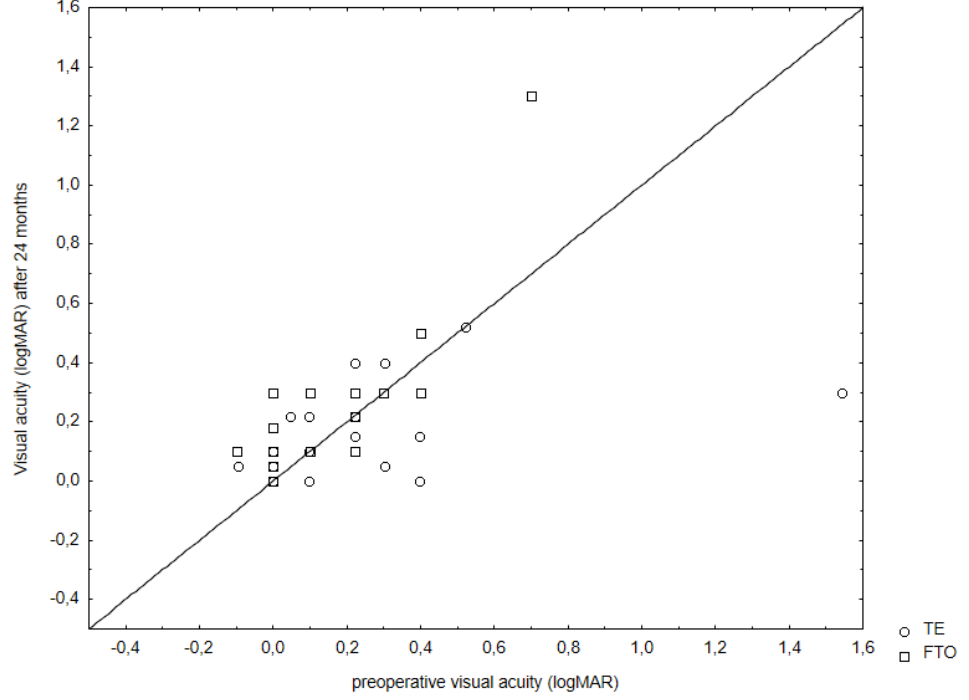
groups, for instance, patients undergoing tube shunt surgery with patients undergoing trabectome surgery 36,37 . By contrast, exact matching is well suited to compare similar pathological conditions and similar treatments, for instance, phaco-iStent or phaco-trabectome 38,39 . A downside of exact matching is that a certain number of datasets must be excluded from the analy- sis because the algorithm accepts only identical primary